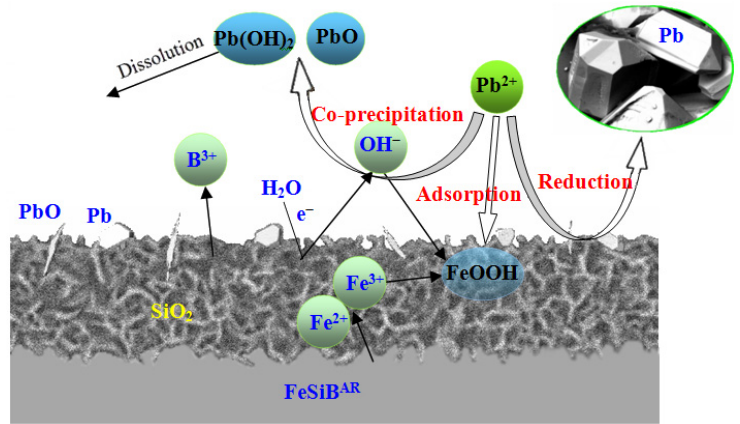
Figure 11. Removal mechanism of FeSiB AR in Pb(II) aqueous solution.